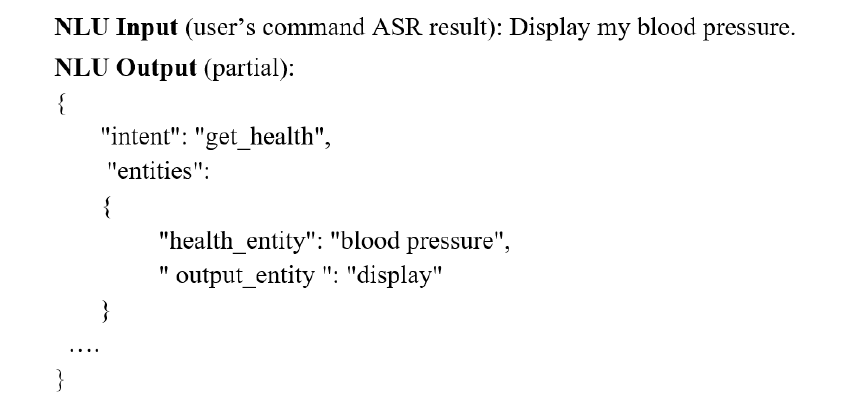
Figure 2. The input and output of the